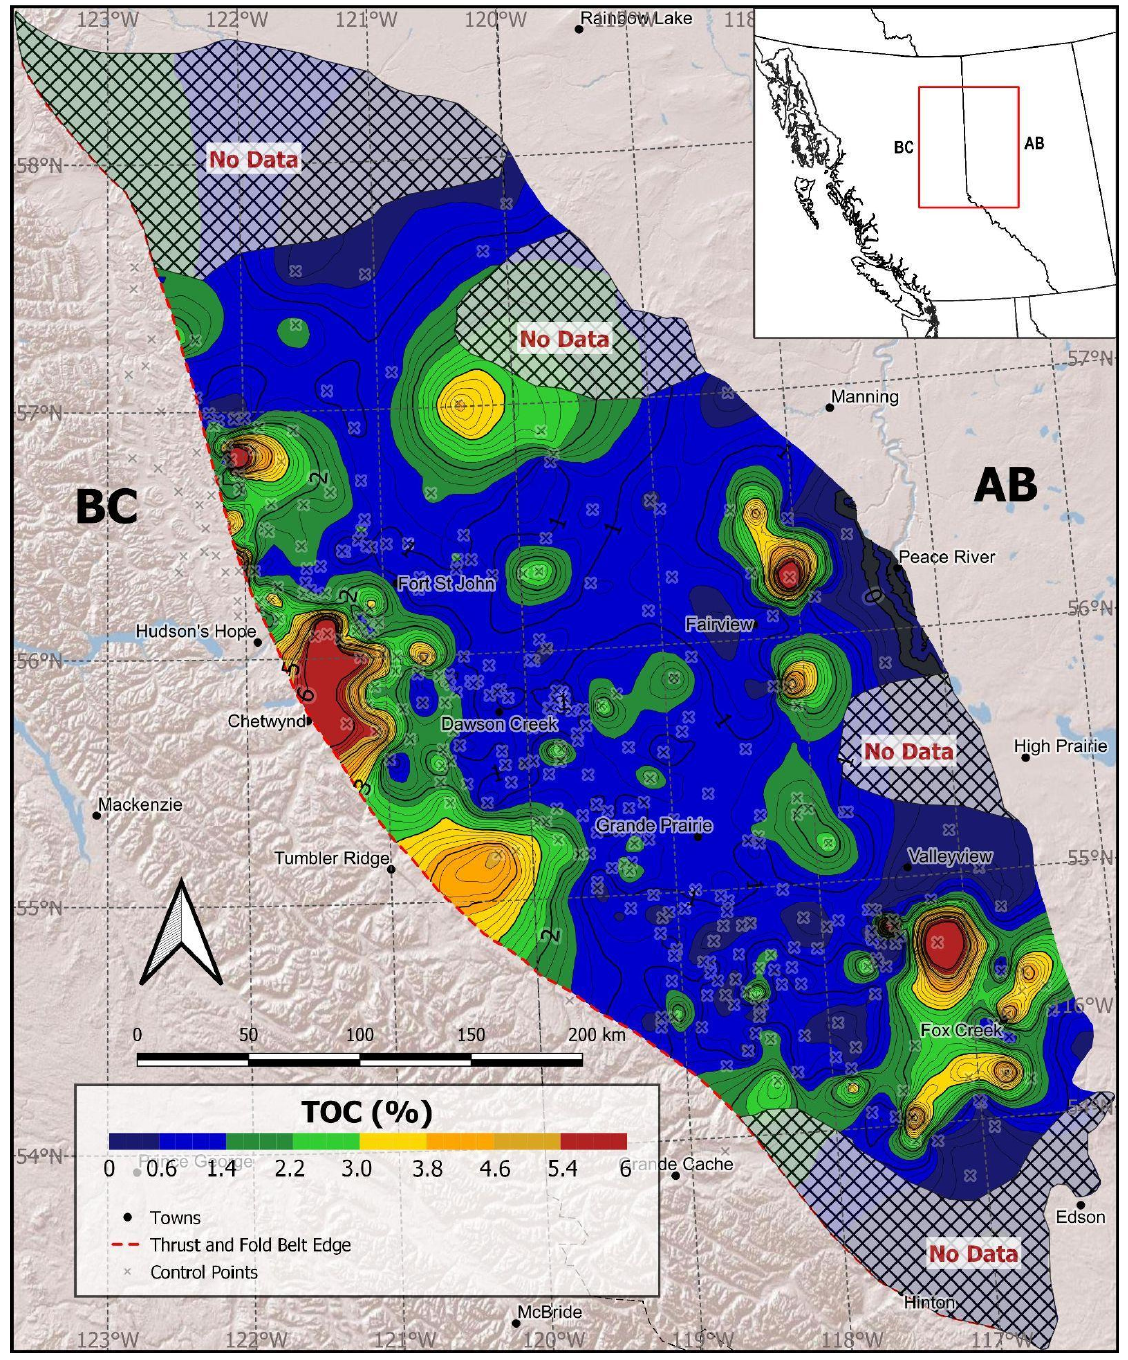
Figure 9. The average total organic carbon (TOC) content distribution of the entire Montney For- mation. Higher TOC contents were observed along the western edge of the basin adjacent to the deformation front, and this may be due to deeper water, anoxic bottom water preserving greater amounts of organic material.